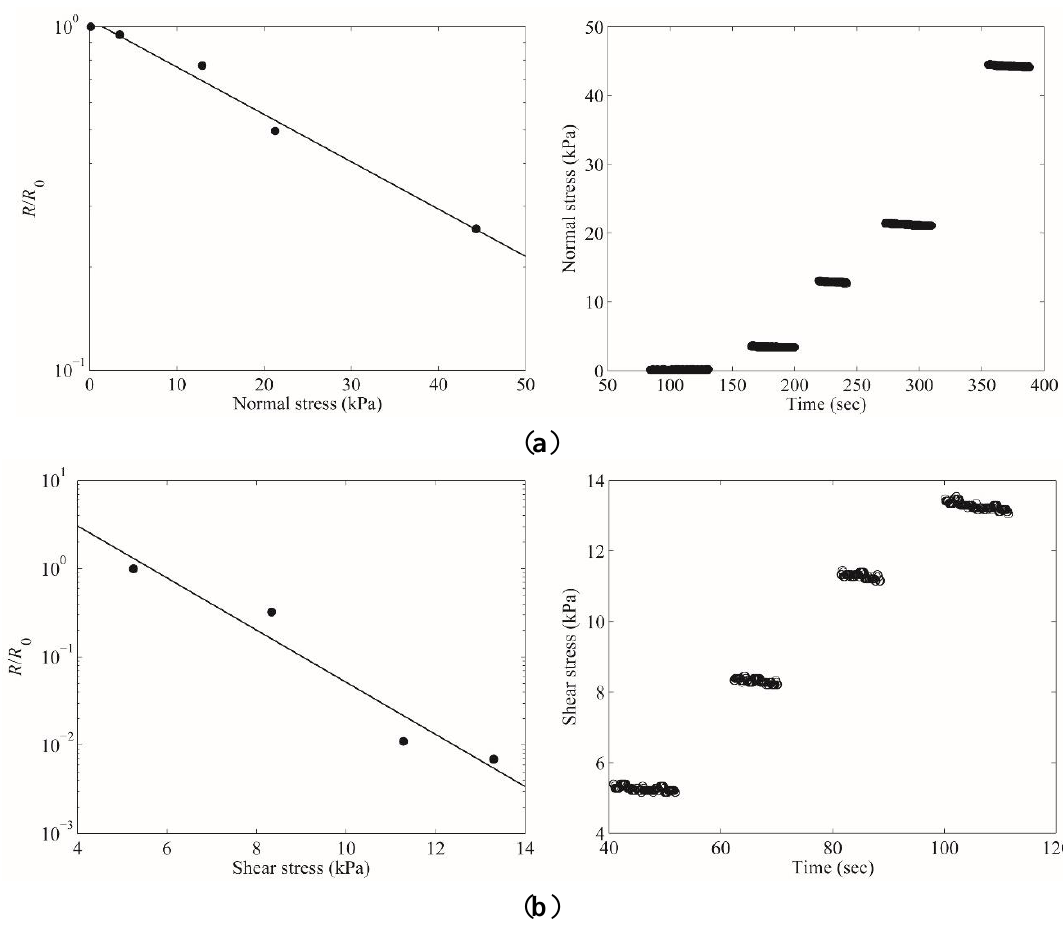
Figure 4. Response to normal and shear stress of the tactile sensor: ( a ) the resistance change in normal pressure sensing element under 128 Pa ~ 44 kPa normal forces; ( b ) the resistance change in shear stress sensing element under 5.28 kPa ~ 12.9 kPa shear